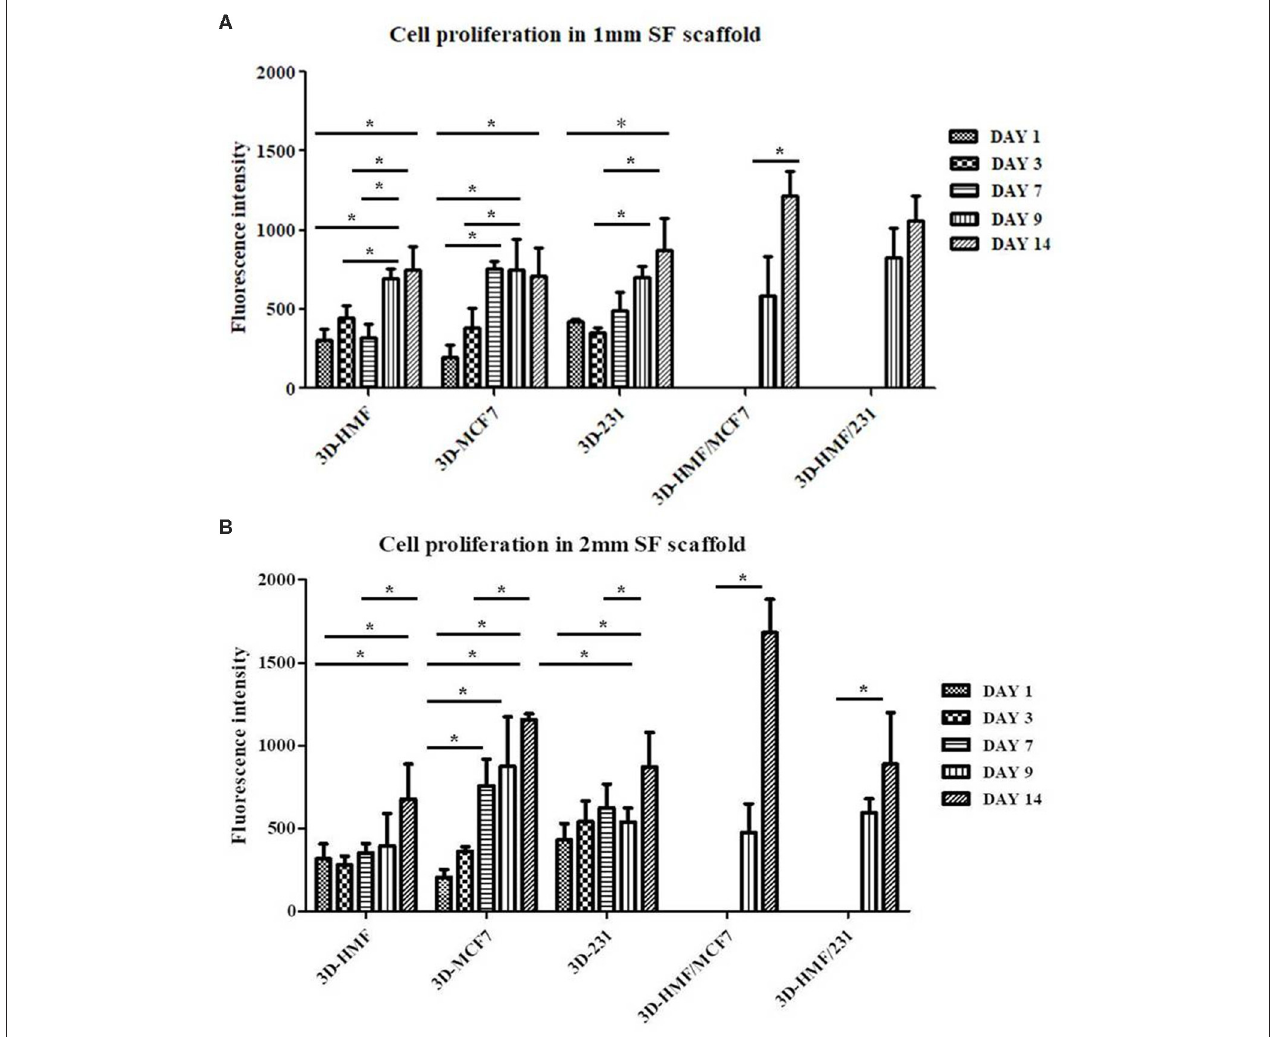
FIGURE 4 | Cell proliferation profile in 1 (A) and 2mm (B) Silk fibroin (SF) scaffolds. The cells proliferation is investigated at different time points (Day 1, 3, 7, 9, 14) for both homotypic and heterotypic 3D-BCMs by mean of Alamar blue assay. * P < 0.05 is considered as statistically significant ( n = 3).